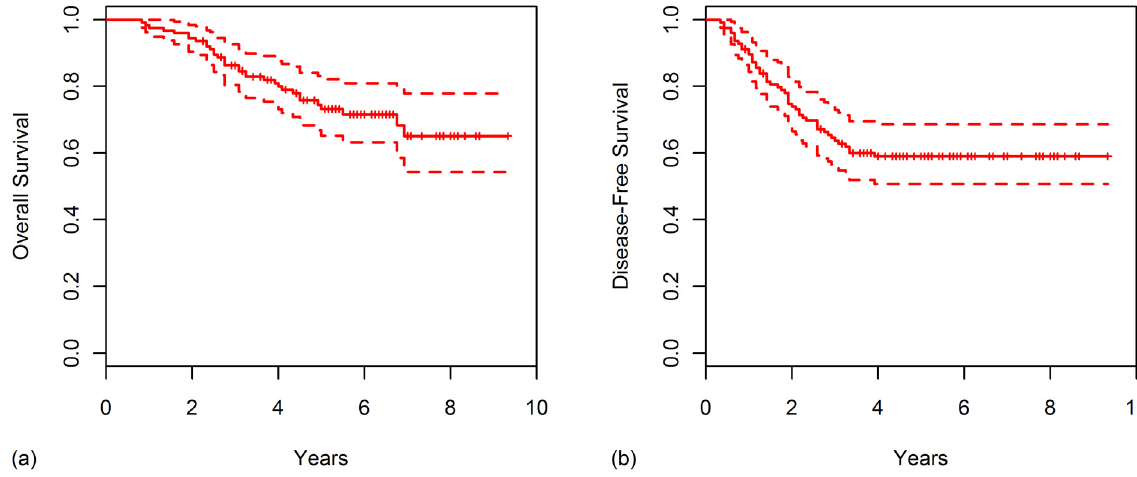
Fig 1. Kaplan-Meier curves for (A) overall survival and (B) disease-free survival for all